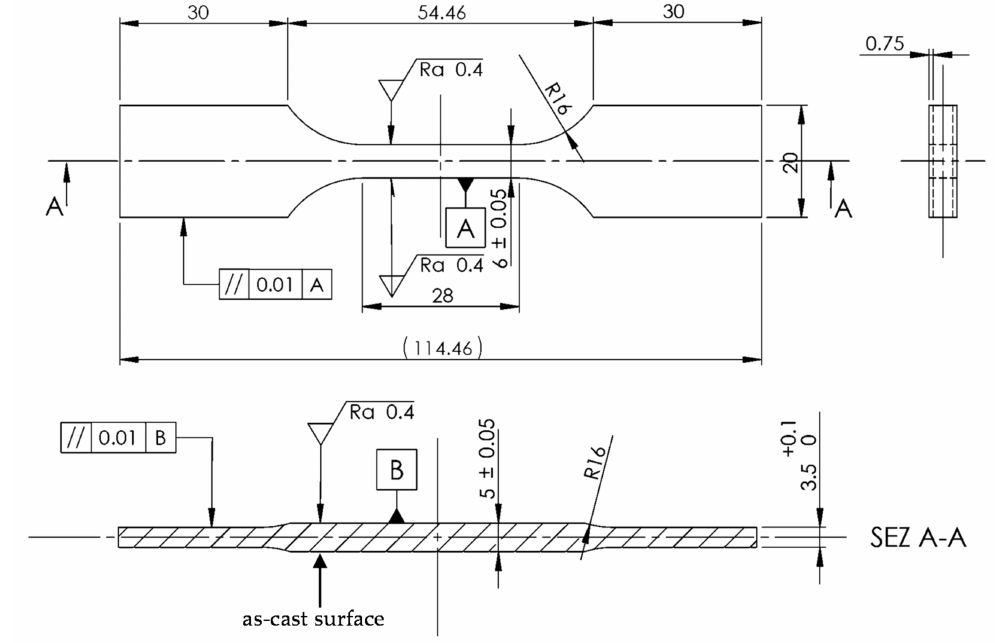
Figure 6. Geometry of plain flat specimens tested under strain-controlled fatigue loading (dimensions are in mm). Specimens have been taken from the axle (see Figure 1 and region 3 of Figure 2), and after that, three surfaces have been machined (Ra = 0.4 µ m), while one has been kept as-cast. It is worth noting that specimens have been taken only from regions 2 (Figures 4 and 5) and 3 (Figure 6) of the off-highway axle shown in Figure 2, while no specimens were taken from region 1, due to the incompatibility of the size of the specimens with the available material in region 1 of the